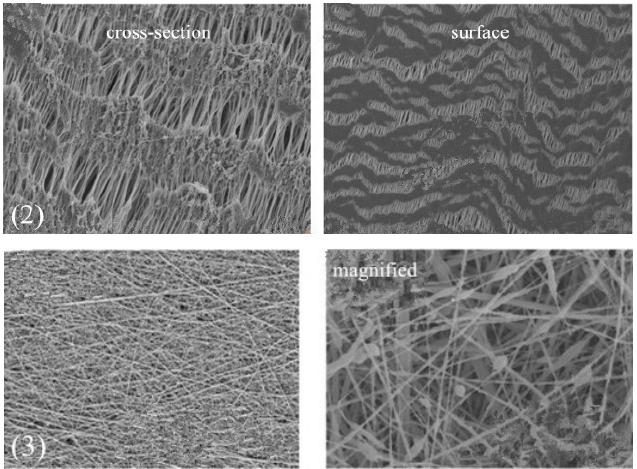
Figure 13. SEM images of different PTFE membrane with ( 1 ) flat sheet; ( 2 ) hollow fiber; and ( 3 ) ultrafine shape [119,121,122].